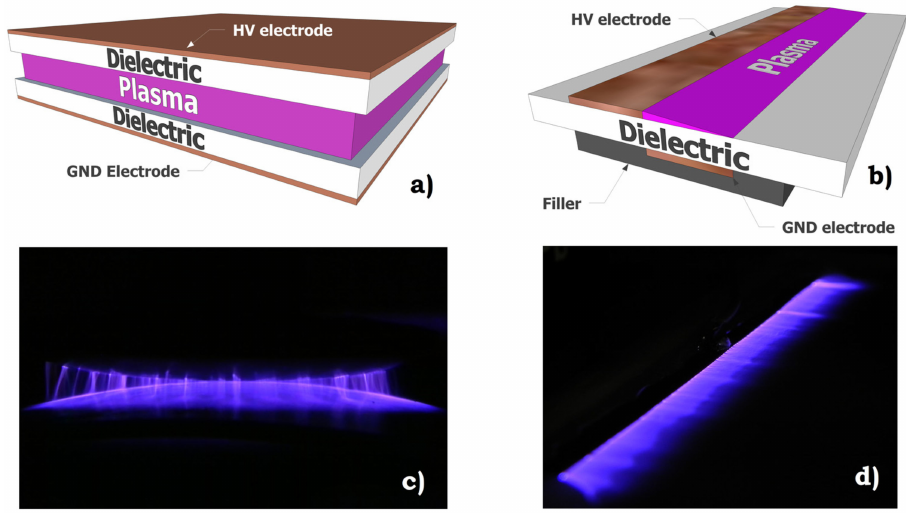
Figure 1. Typical ( a ) volumetric and ( b ) surface reactor sketches and corresponding images of a volumetric discharge with ( c ) hemispherical electrodes and ( d ) a surface dissymmetric discharge.